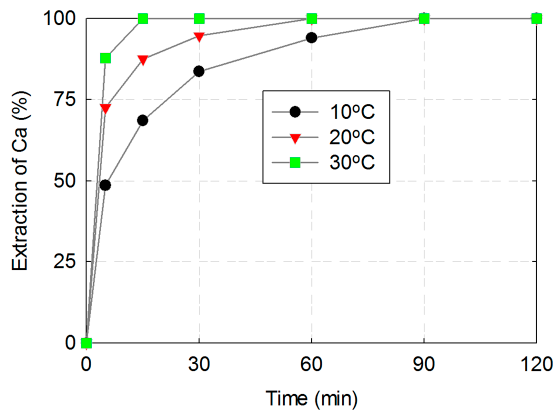
Figure 5. Ca dissolution from blast furnace slag using an aqueous solution of 5% acetic acid.